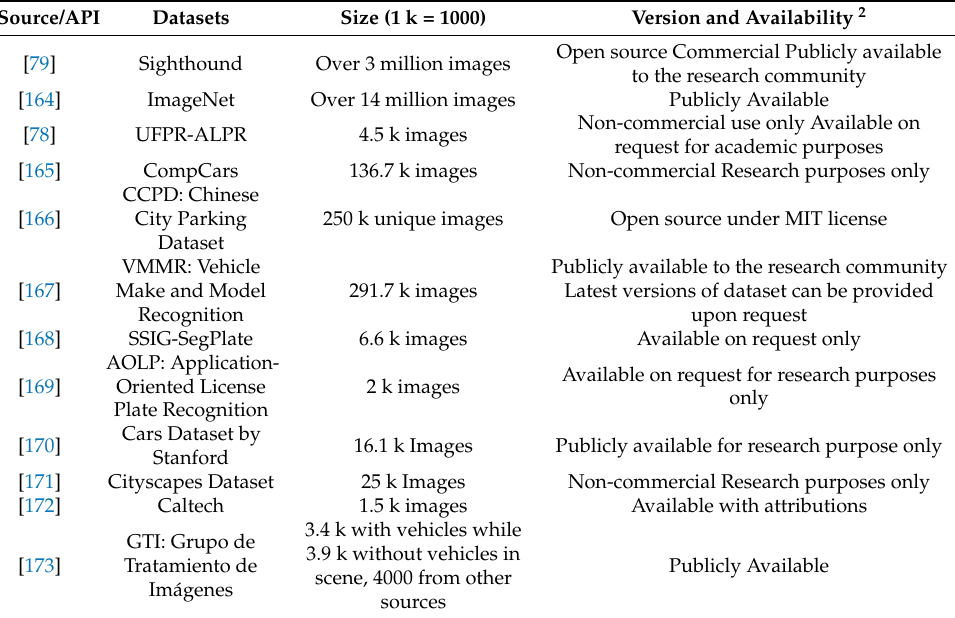
Table 3. ANPR Datasets available to the research